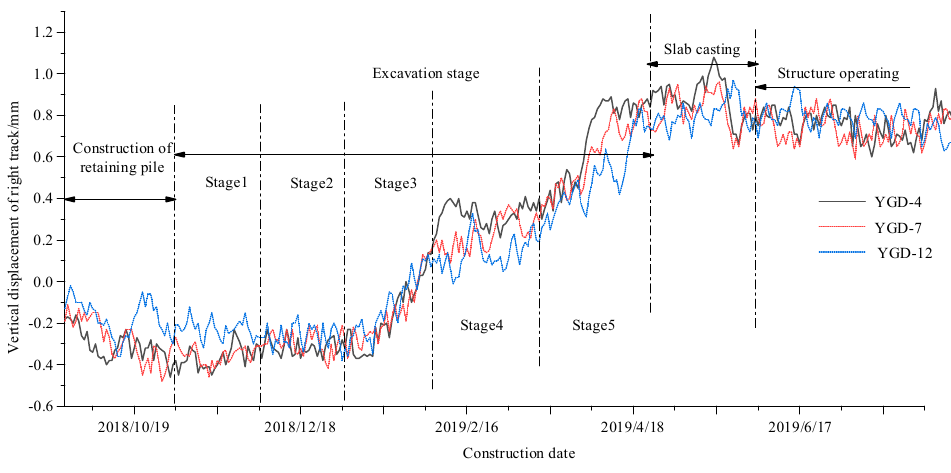
Figure 14. Vertical displacement time − history curve of the right track. Figure 15 shows that the horizontal displacement of the right track continues to increase at all stages of foundation pit excavation construction, and the horizontal displacement deformation trend of each measuring point shifts to the pit. The maximum horizontal displacement of the track is 1.4 mm.